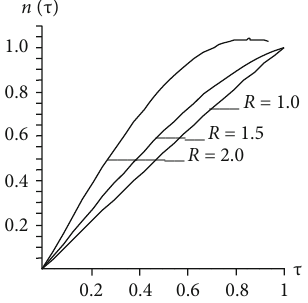
Figure 7: Fluid temperature for various values of R with q = 1 : 0 , N = 1 : 0 , A = 1 : 0 , and ji ′ = π /4 .